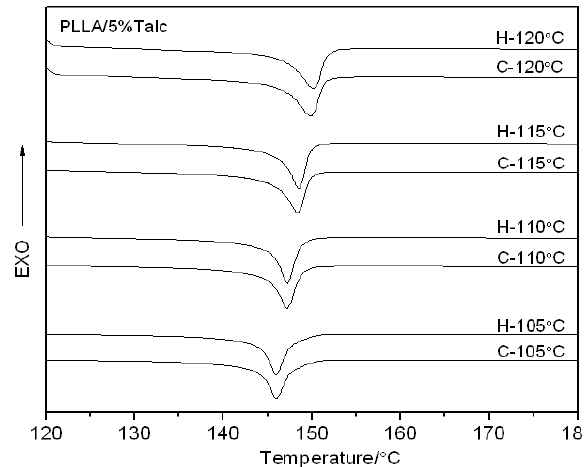
Figure 4. Melting behavior of PLLA/5%talc composites after cold isothermal crystallization and hot isothermal